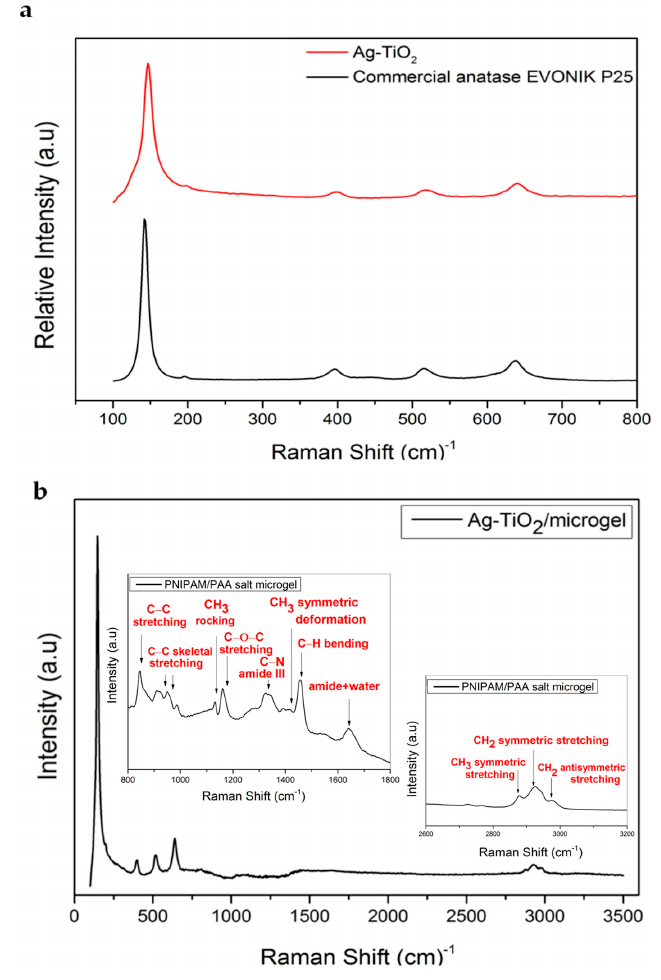
Figure 6. Raman spectra of ( a ) Ag-TiO 2 nanoparticles compared with commercially available Evonik P25 TiO 2 anatase and ( b ) PNIPAM/PAA microgel/Ag-TiO 2 . The insets depict a part of the Raman spectrum of PNIPAM/PAA salt microgel.